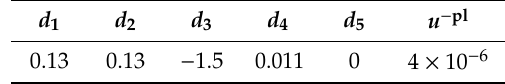
Table 7. Johnson–Cook failure model parameters for matrix